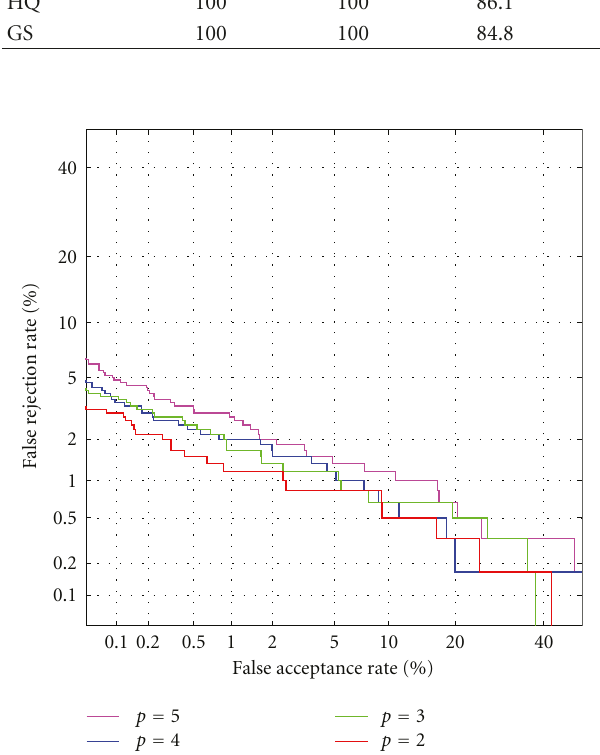
Figure 17: DET curves generated for di ff erent numbers of filter scales used for computing the OGPCIs.